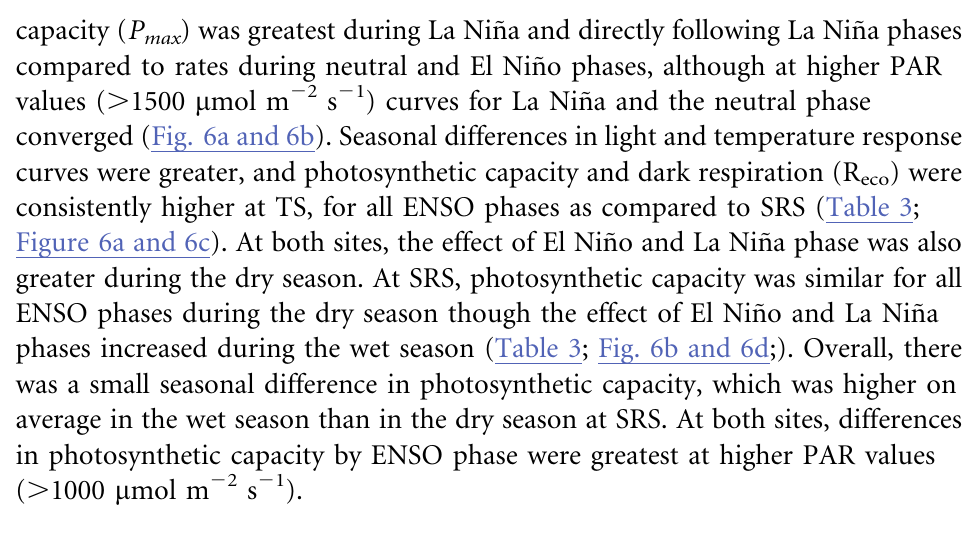
Fig. 6. Light and Temperature Response Curves. Light response curves showing differences in photosynthetic capacity by ENSO phase during the wet season at (a) TS and (b) SRS, and during the dry season at (c) TS and (d) SRS. Temperature response curves showing differences in the relationship between ecosystem respiration rates and temperature by ENSO phase during the wet season at (e) TS and (f) SRS, and during the dry season at (g) TS and (h) SRS. The shaded region highlights the wet season. At TS, there were 576 days (322 wet season; 254 dry season) in a La Nin˜a phase, 304 days (188 wet season; 116 dry season) in an El Nin˜o phase, 326 days (85 wet season; 241 dry season) in a post-La Nin˜a phase, and 61 days (12 wet season; 49 dry season) in the post-El Nin˜o phase, and 559 days (394 wet season; 165 dry season) in the neutral phase. At SRS, there were 576 days (308 wet season; 268 dry season) in a La Nin˜a phase, 304 days (151 wet season; 153 dry season) in an El Nin˜o phase, 326 days (85 wet season; 241 dry season) in a post-La Nin˜a phase, 61 days (58 wet season; 3 dry season) in the post-El Nin˜o phase, and 559 days in the neutral phase (401 wet season; 158 dry season).